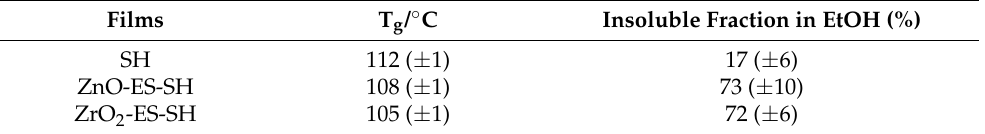
Table 1. Glass transition temperatures determined for coating films and their insoluble fractions in alcohols (three independent measurements on each sample were done in order to obtain the average values).